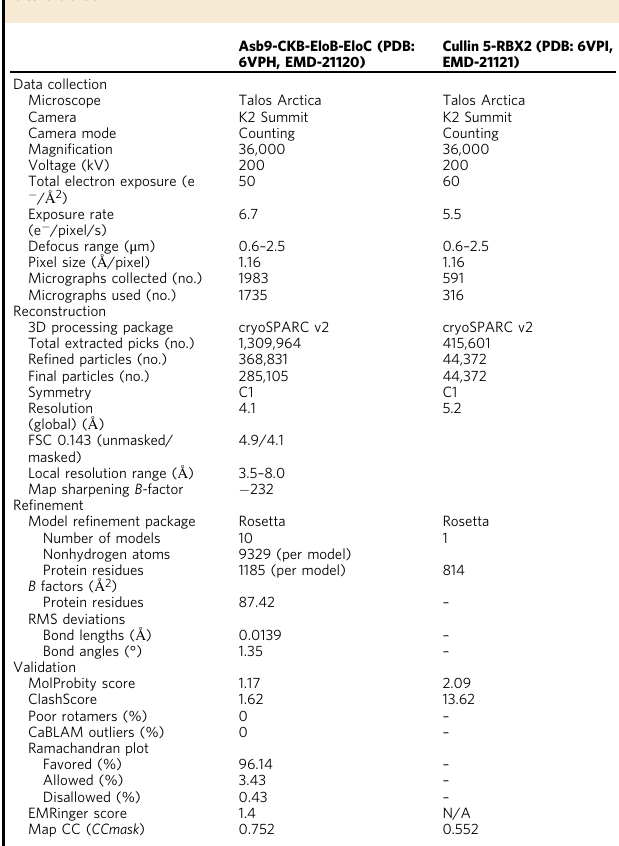
Table 1 Cryo-EM data collection, re fi nement, and validation